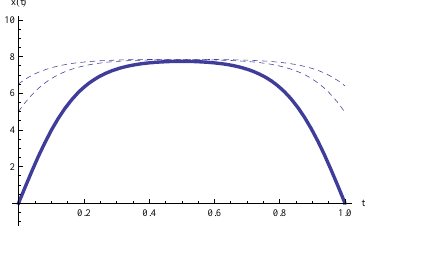
Figure 3. Some approximations of 2 - type